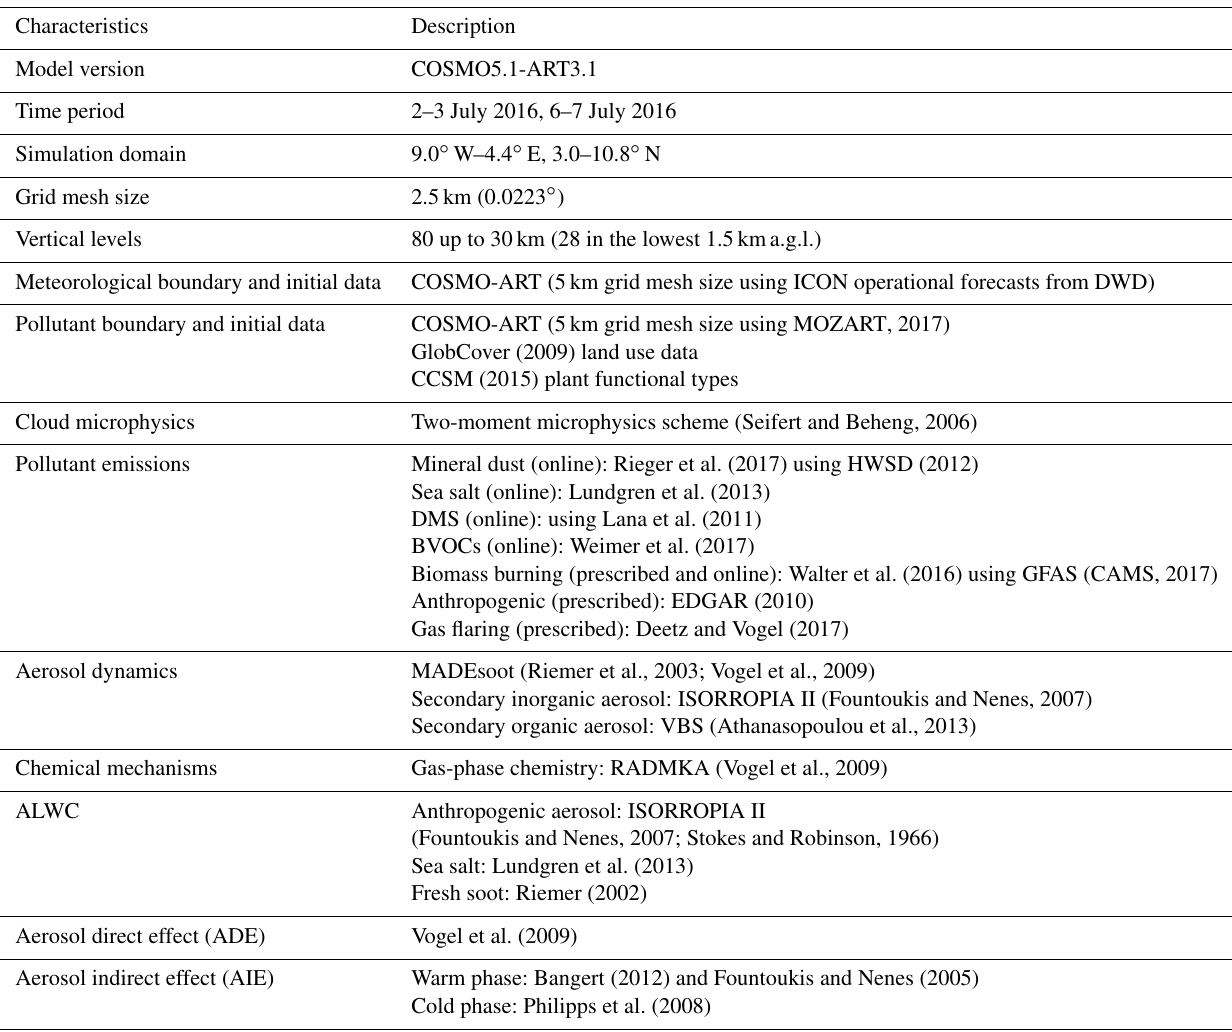
Table A1. COSMO-ART model configuration used for this